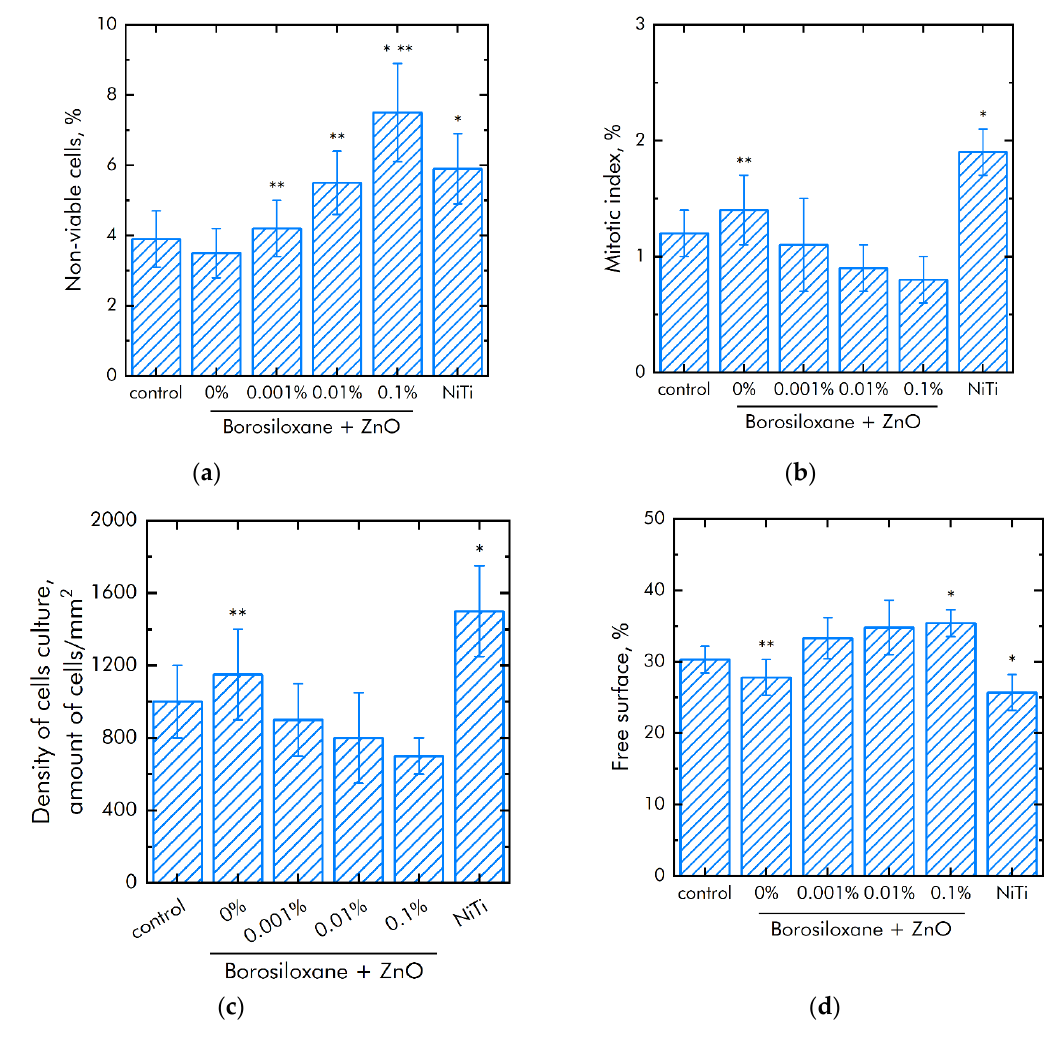
Figure 8. Effect of composite material based on borosiloxane and zinc oxide nanoparticles on the main characteristics of cell culture SH-SY5Y growth and development: ( a ) Cell viability; ( b ) Mitotic index of a cell population; ( c ) Cell culture density; ( d ) Colonization rate; * indicate a significant difference at 5% level in comparison with the control ( p < 0.05). ** indicate a significant difference at 5% level in comparison with the NiTi group ( p < 0.05). Data are presented as mean values and standard errors.